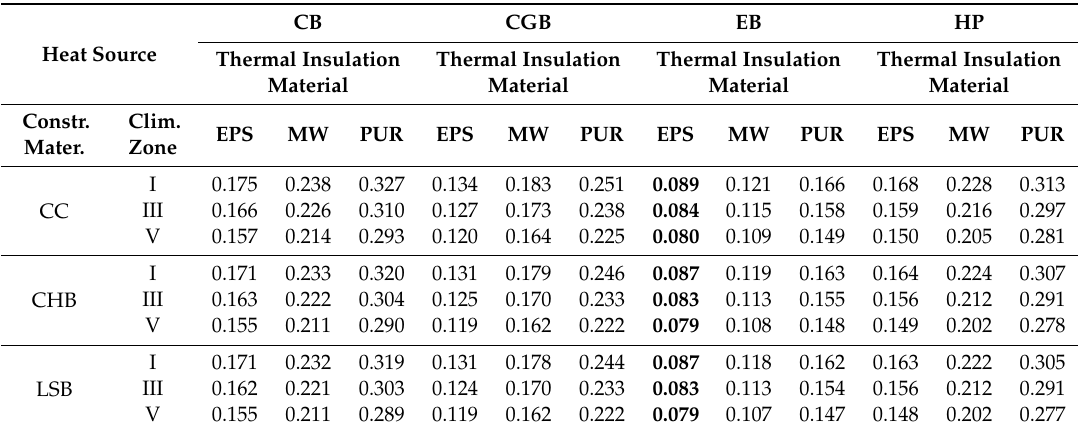
Table 5. Heat transfer coe ffi cient U opt values [W / (m 2